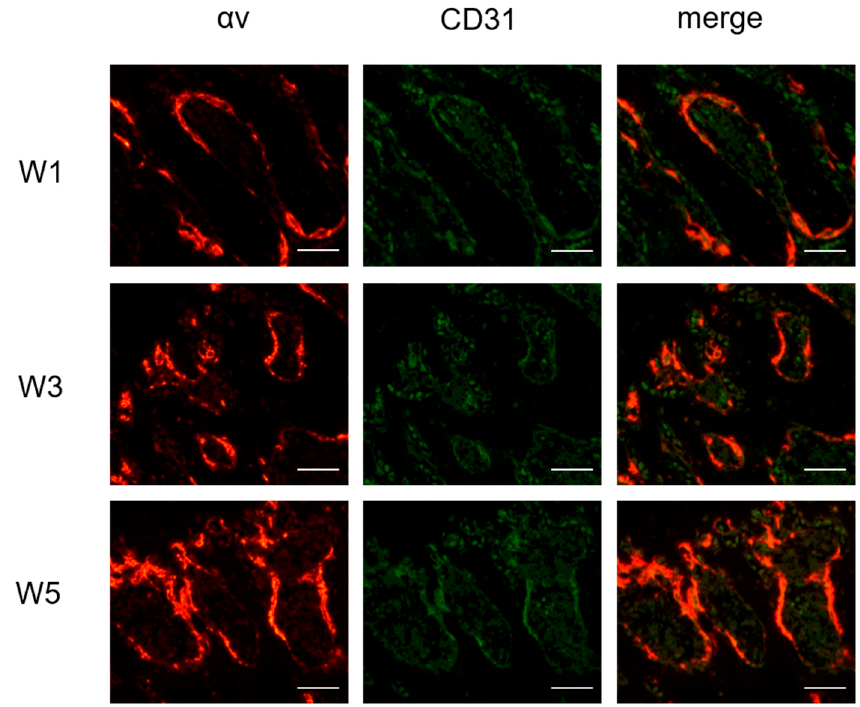
Figure 6. Immunofluorescence staining assay for av and CD31 expression on the ONFH section. Integrin α v and blood vessel in ONFH were stained with fluorescence-labeled anti- α v and CD31 antibodies. Immunofluorescence images of integrin α v staining red (first column), immunofluorescence images of CD31 blood vessel staining green, and images obtained by merging (red and green) (third column). Bar = 100 µm.